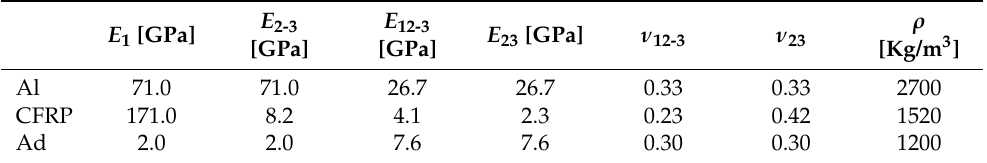
Figure 1. Test article liner ( a ) and the whole structure obtained by filament winding process ( b ) [16]. Table 1. Mechanical properties of aluminum layer (Al), composite material (CFRP), and adhesive layer